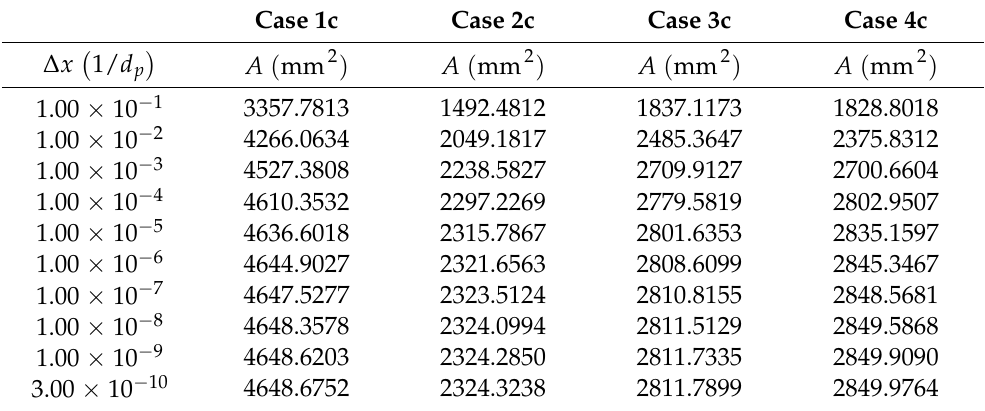
Table 6. Convergence analysis for Equation (23)